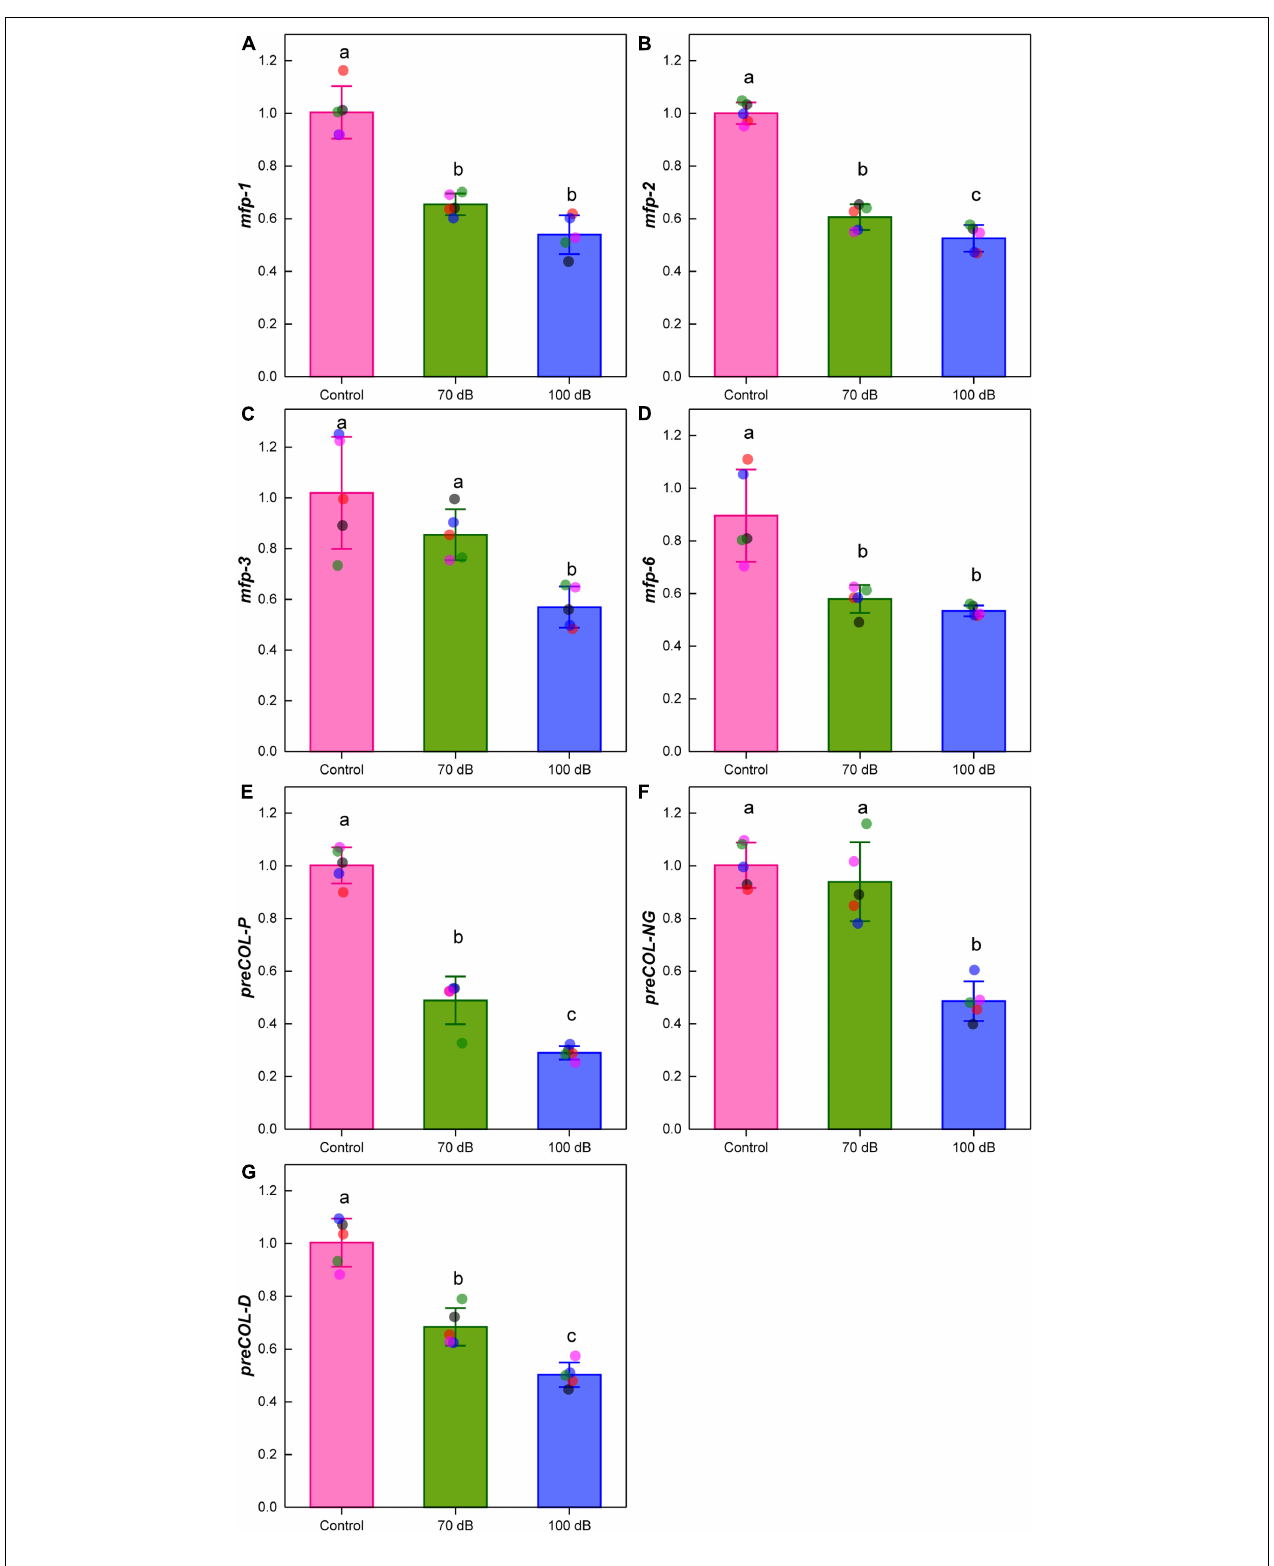
FIGURE 6 | Effects of anthropogenic noise exposure on the expression levels of genes encoding structural proteins of byssal threads, including (A) mfp-1, (B) mfp-2, (C) mfp-3, (D) mfp-6, (E) preCOL-P, (F) preCOL-NG and (G) preCOL-D in the thick shell mussel Mytilus coruscus ( n = 5 per group, mean ± SD). Means not sharing the same superscript are significantly different (Tukey’s HSD, p <